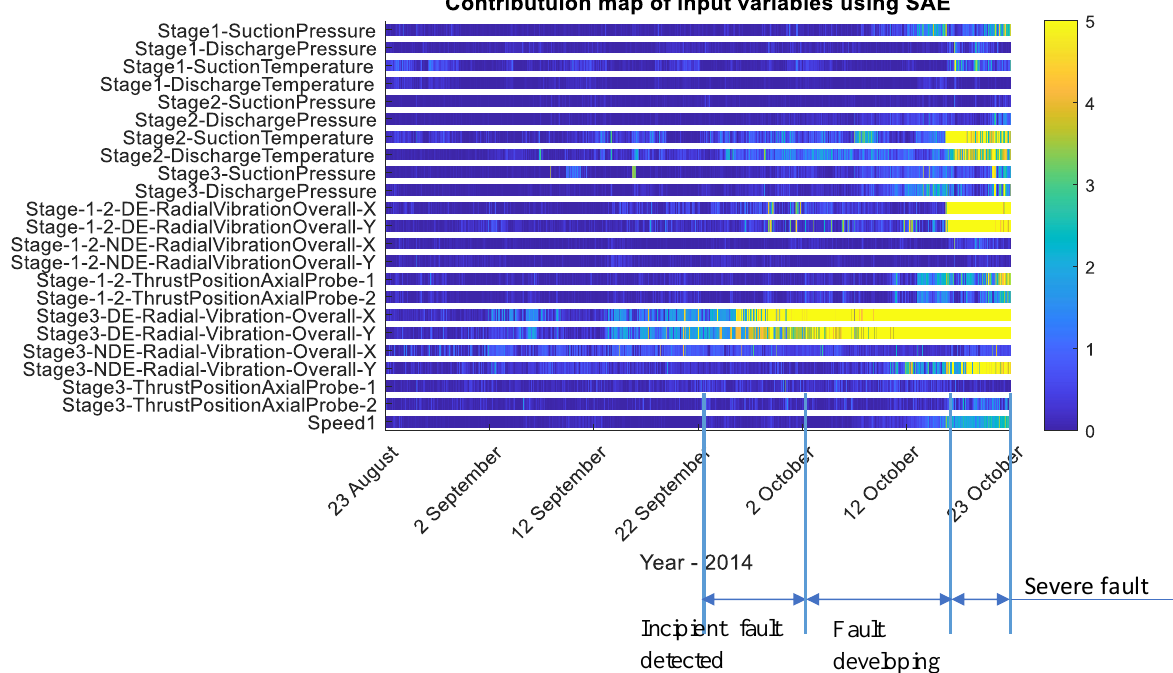
Figure 18. Q statistic contribution map by SAE model from 23 August to 23 October 2014.